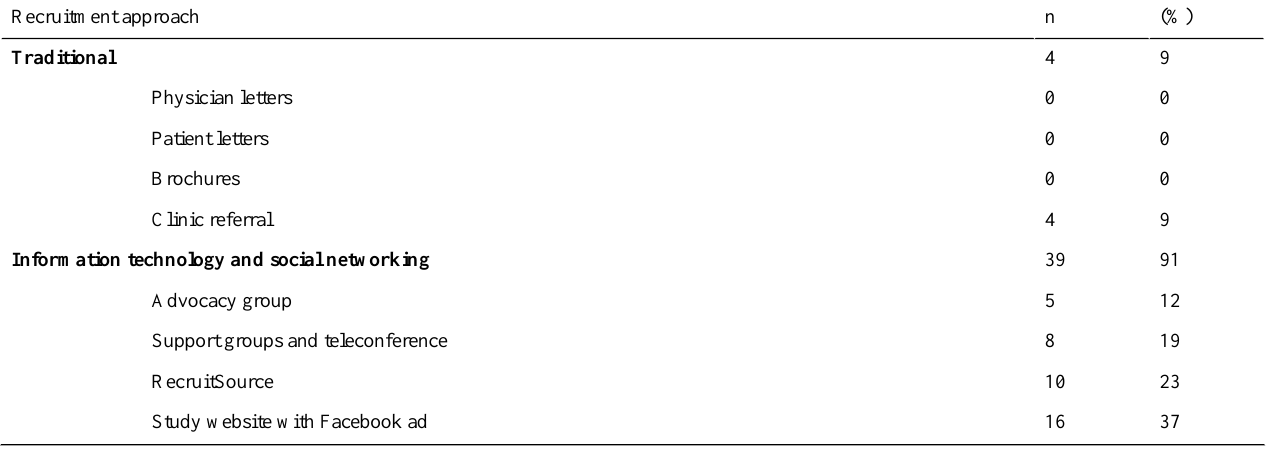
Table 1. Number of participants using traditional and information technology with social networking recruitment approaches to the Klinefelter syndrome study